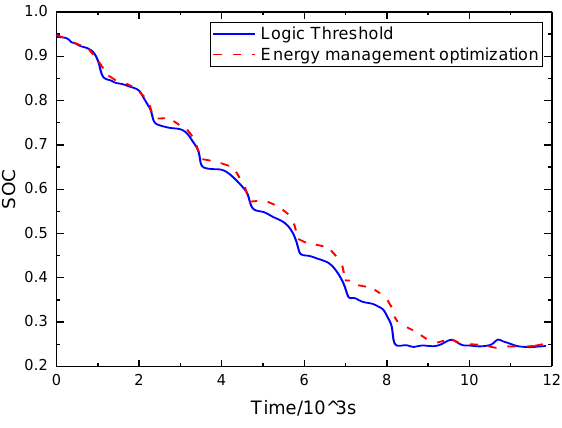
Figure 17. SOC change curve.